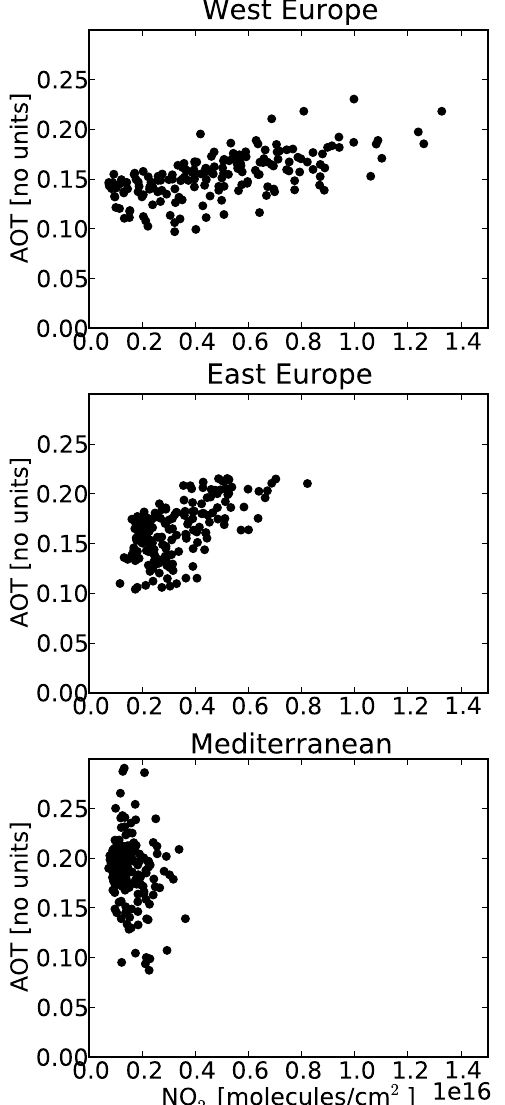
Fig. 2. Scatter plots between the AOT and NO 2 for the three ar- eas indicated in Fig. 1: western Europe (top panel), eastern Eu- rope (middle panel) and Mediterranean basin (bottom panel). The AOT and tropospheric NO 2 are averages over the period 2005–